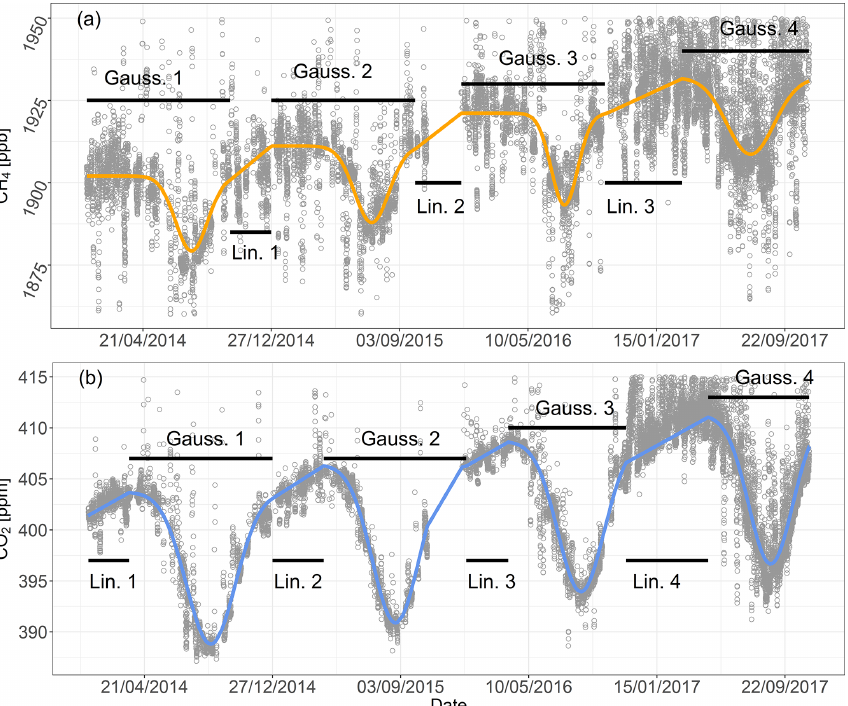
Figure 5. Hourly time series filtered for westerly wind directions (range 150–210 ◦ ) measured at the Mace Head station (open circles) of (a) CH 4 and (b) CO 2 mole fractions. Smoothing and gap filling of the original time series was achieved by applying linear (Lin.) and non-linear (Gauss.) regressions by parts for the data period 1 January 2014–31 December 2017 (solid lines).